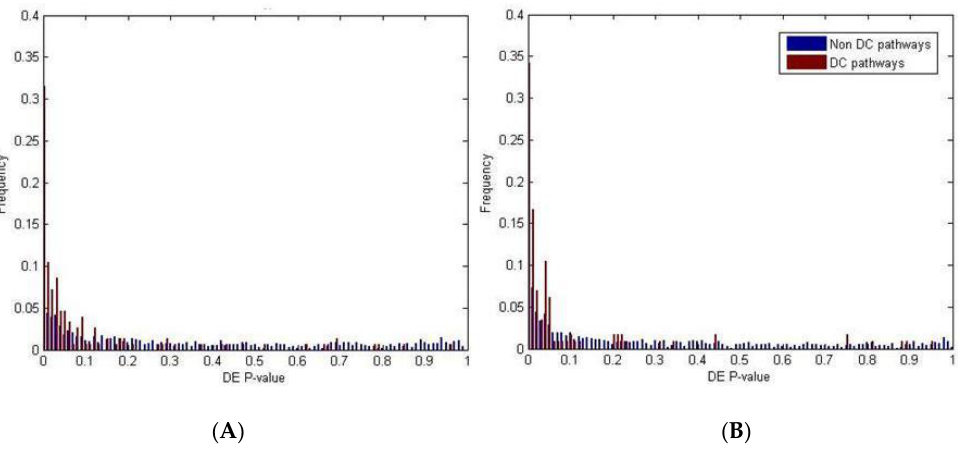
Figure 3. Frequencies of the differentially expressed (DE) p -values for the canonical pathways ( A ) and the Gene Ontology terms ( B ). The DE p -values for the differentially co-expressed (DC) pathways are plotted in red, while the DE p -values for the non-DC-pathways are plotted in blue. Most of the DC pathways have DE p -values < 0.05.